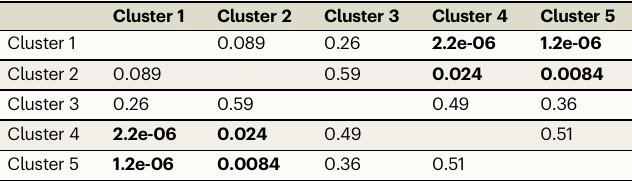
Table 1 | Pairwise comparison of the cumulative magnitude distribution of each cluster against the others Cluster 1